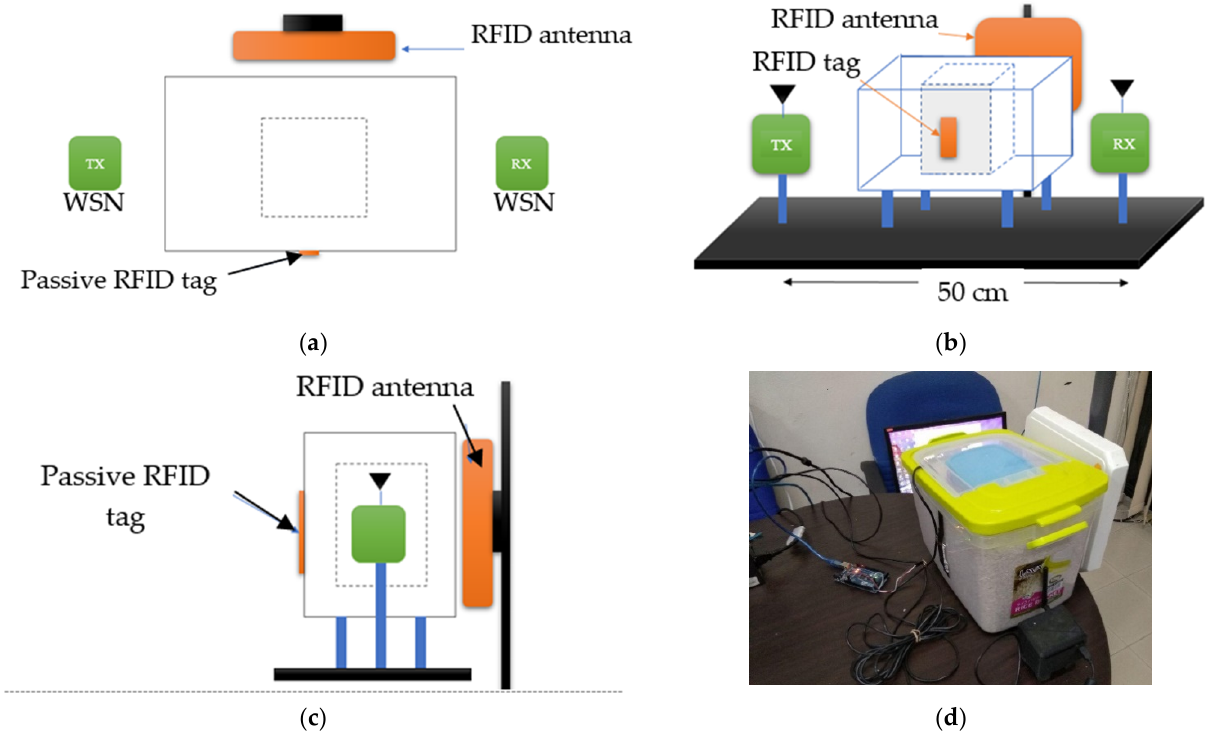
Figure 3. The experimental setup considering the Fresnel zone clearance: ( a ) the top view; ( b ) front view; ( c ) the side view of the experimental testbed layout; ( d ) a picture of the setup.